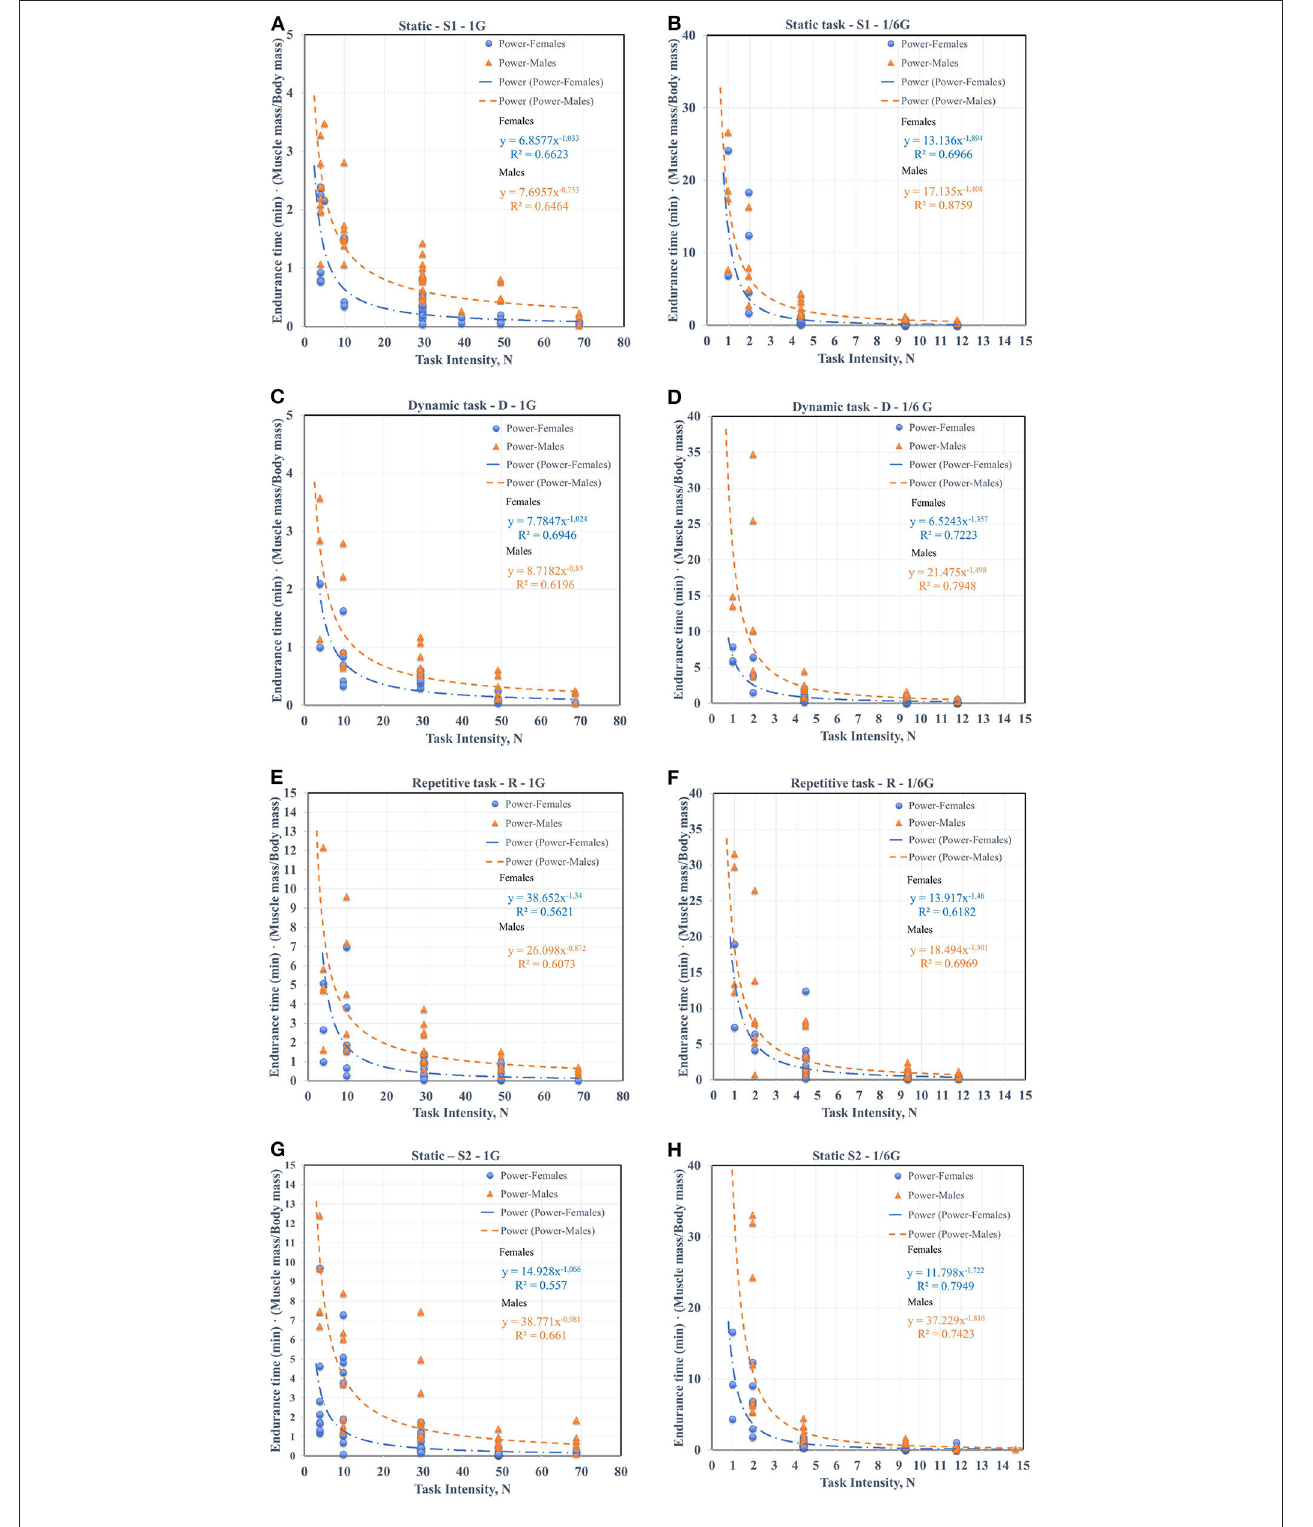
FIGURE 2 | The ET power models ( N = 520 studies, 6 task intensities, (A) static task (S1)-1G, (B) static task (S1) 1 ⁄ 6 G, (C) dynamic task (SD)-1G, (D) dynamic task (D)- 1 ⁄ 6 G, (E) repetitive task (R)-1G, (F) repetitive task (R)- 1 ⁄ 6 G, (G) static task (S2)-1G, and (H) static task (S2)- 1 ⁄ 6 G.